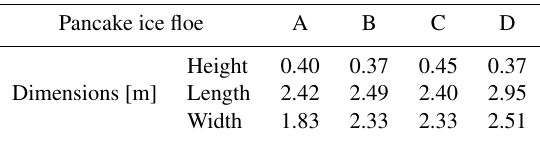
Table 2. Overview of pancake ice floe